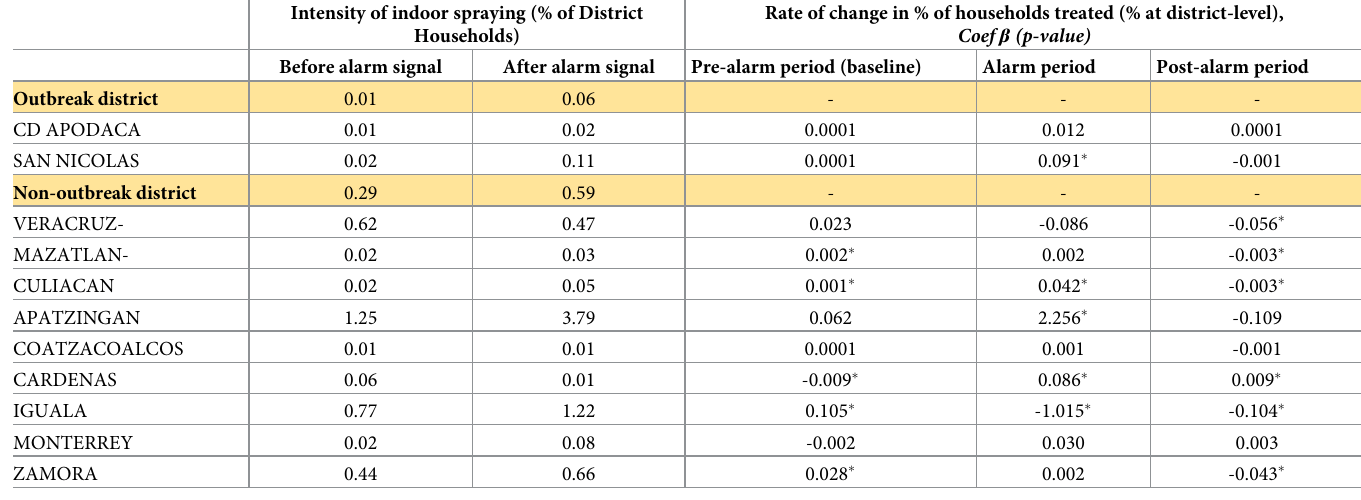
Table 6. Intensity of indoor spraying before and after the alarm signal across two outbreak-districts and nine non-outbreak districts with alarm signals with the rate of change (from before to after alarm period). Intensity of indoor spraying (% of District